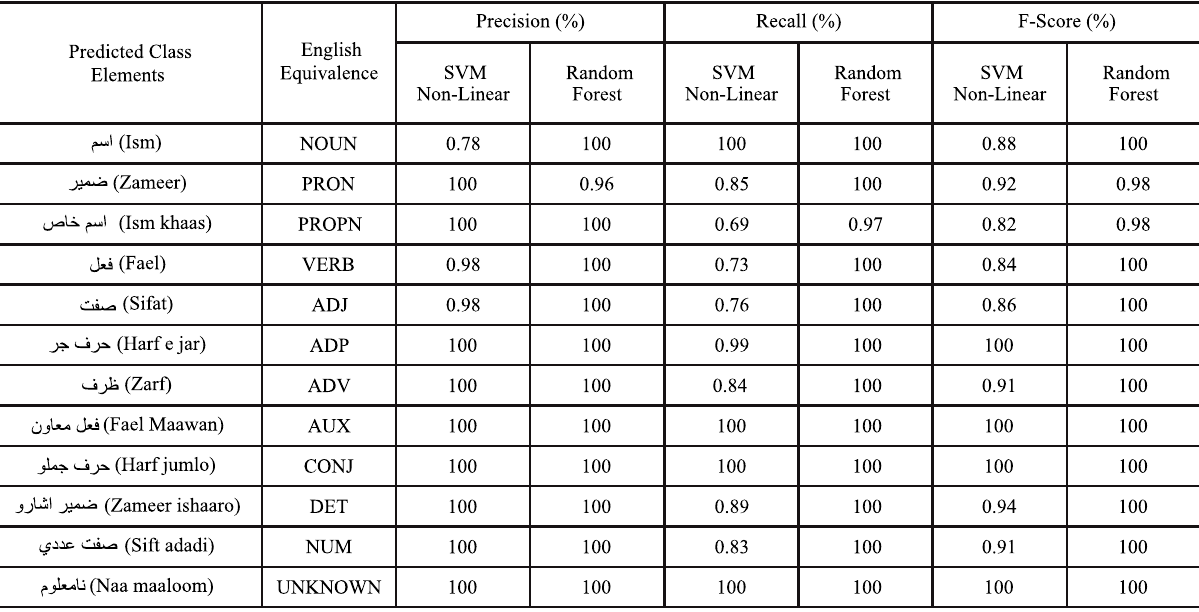
TABLE 8. COMPARISON OF PRECISION, RECALL AND F1 SCORE TARGETING CLASS SPOS